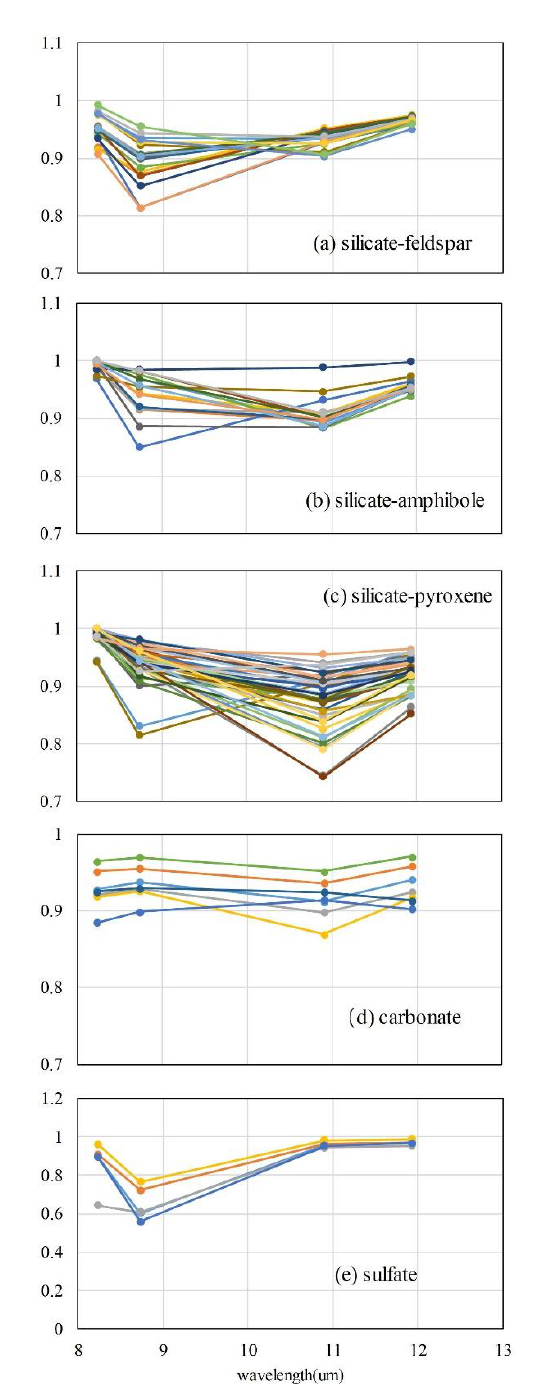
Figure 4. GF-5’s TIR band emissivities of minerals in ASU library.